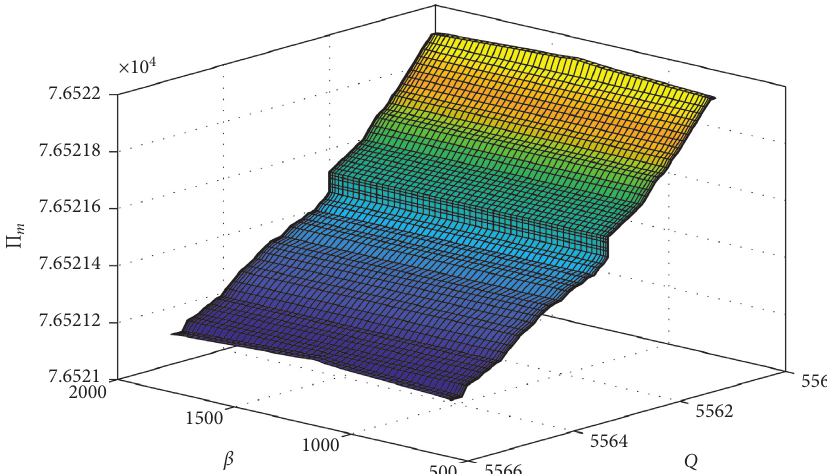
Figure 7: The impact of carbon emission reduction cost factors and order quantities on manufacturers’ earnings under decentralized